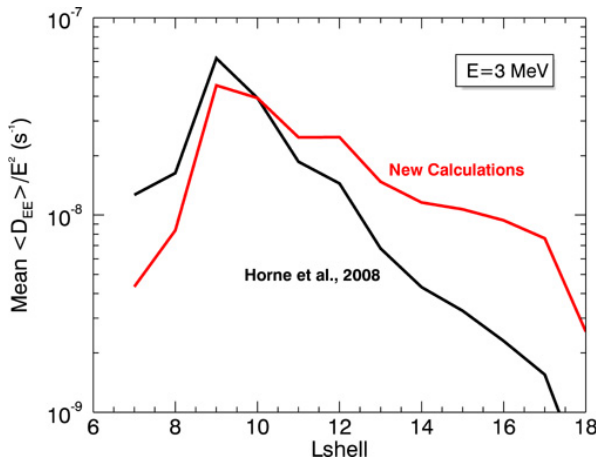
Fig. 1. Mean energy diffusion coefficients (averaged over all pitch angles) for our new results and those of Horne et al.